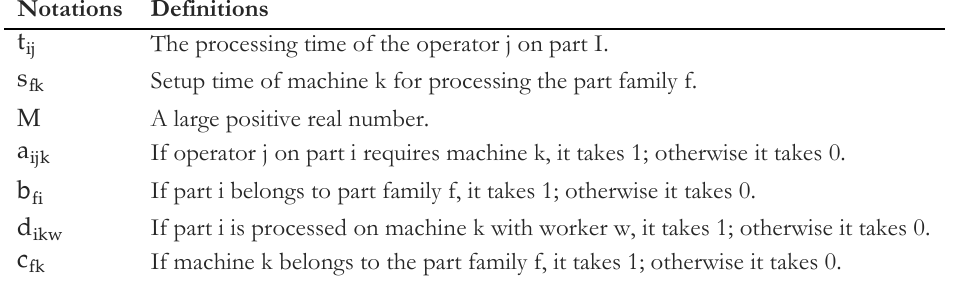
Table 2. Definitions of